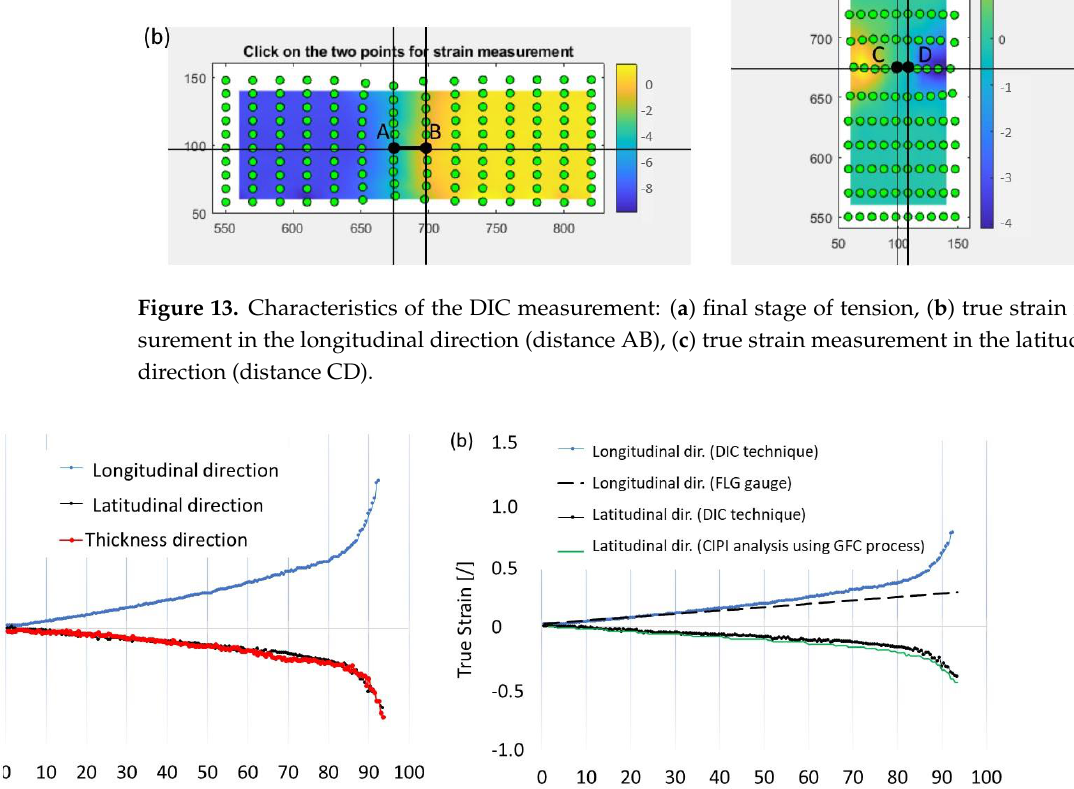
Figure 14. Comparison of results for the strain components: ( a ) for the DIC technique, ( b ) for the image processing using fibre-lighting gauge and contour measurement.